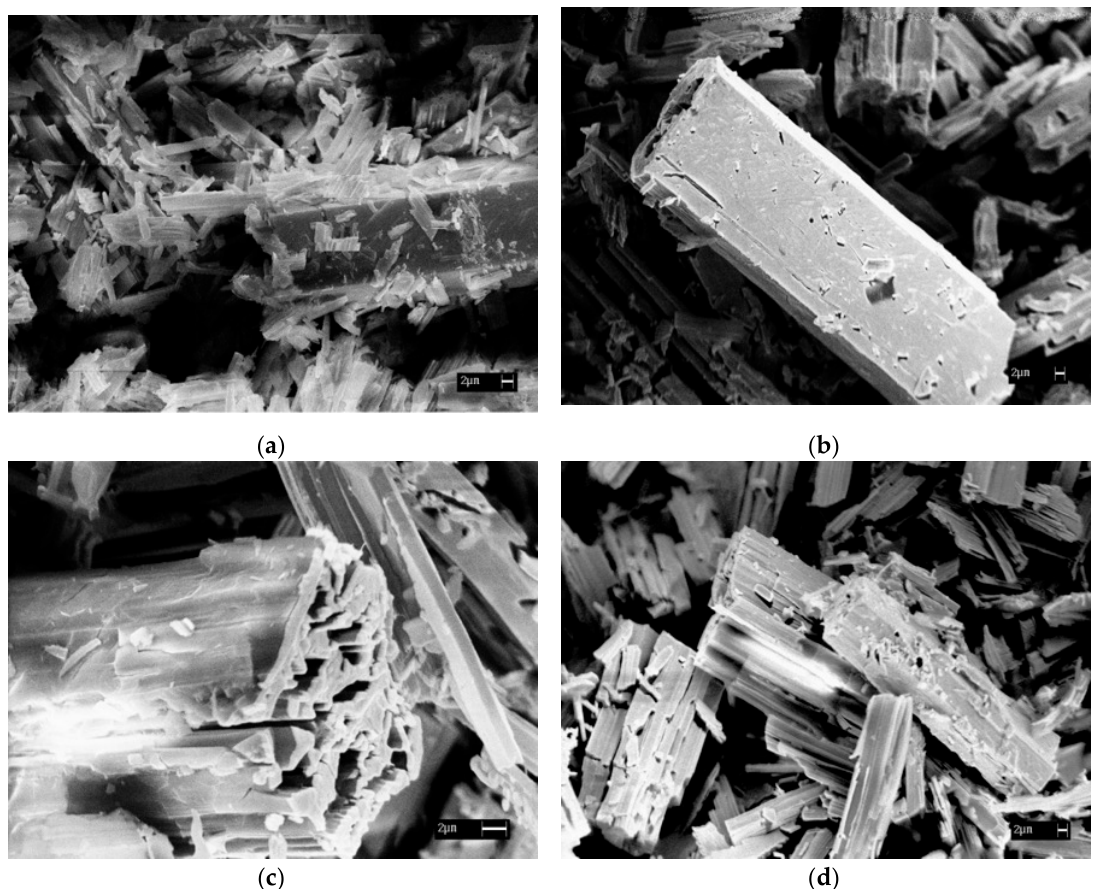
Figure 3. Electronic micrographics of starting [Co(NH 3 ) 6 ][Fe(C 2 O 4 ) 3 ] ∙ 3H 2 O single-source precursor ( a ) and intermediate I-1 ( b – d ).